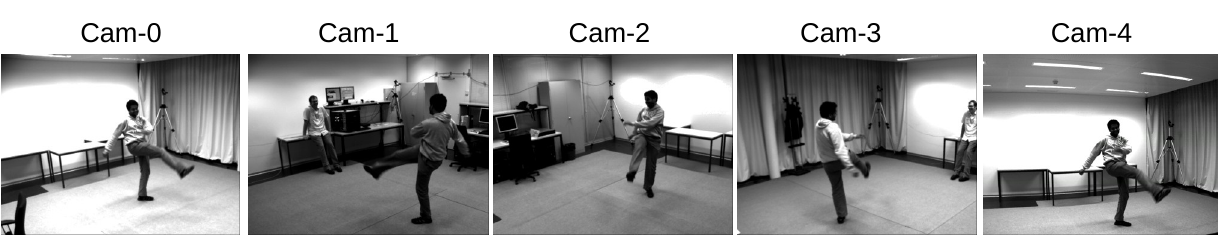
Figure 2. An example of all the camera views in the IXMAS actions